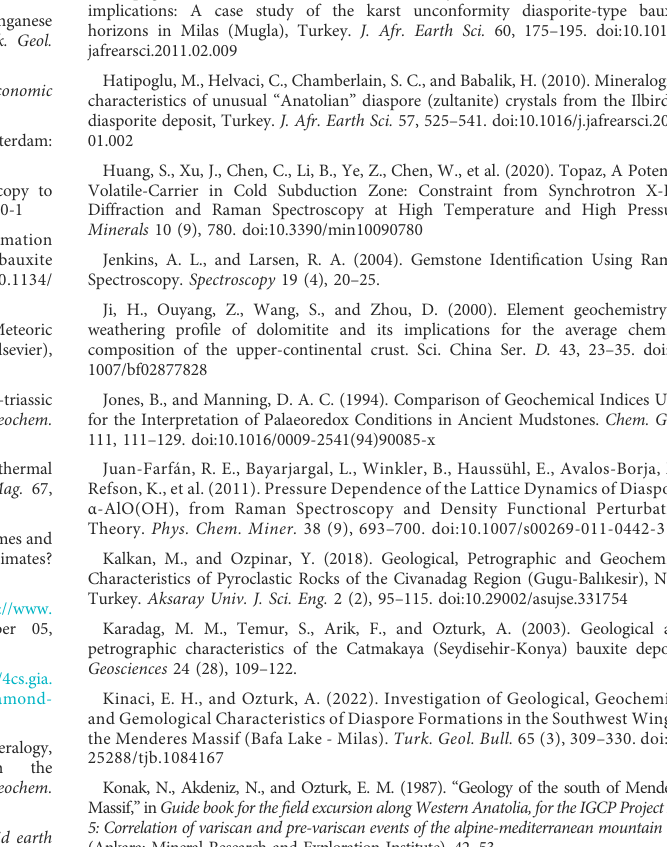
SUPPLEMENTARY FIGURE S11 The image of the diaspore samples collected from the fi eld (A) Round- BrilliantCut(GIA,2016). (B,C) Theimageofthesamplecutfromthesamples under yellow light and white light. SUPPLEMENTARY FIGURE S12 Schematic representation of the technique used on diaspore samples collected from the fi eld (Gemmology Project, 2022). SUPPLEMENTARY FIGURE S13 Cr-Ni diagram showing the distribution of Bauxite-Diaspore formations in the study area (Sinisi, 2018). SUPPLEMENTARY FIGURE S14 (A) : V/(V + Ni) (Hatch and Leventhal, 1992). and Ni/Co; (Jones and Manning, 1994) diagram (Rimmer, 2004; Aydogan, 2021). (B) : Diagram showing oxic, semi-oxic, anoxic, and redox conditions (Wright et al., 1987; Hatch and Leventhal, 1992; Jones and Manning, 1994; Aydogan, 2021). SUPPLEMENTARY FIGURE S15 Diagram of Sm/Nd and Eu/Eu* (A) TiO 2 /Al 2 O 3 and Eu/Eu* (B) outlining the comparison between mean standard lithologies (Viers and Wasserburg,